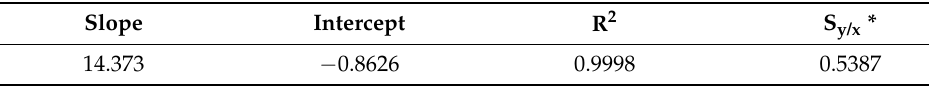
Figure 6. AA calibration curve. Concentration range 0.91–9.11 mg/mL. A.U.: arbitrary unit. Table 5. Regression parameters of the method.